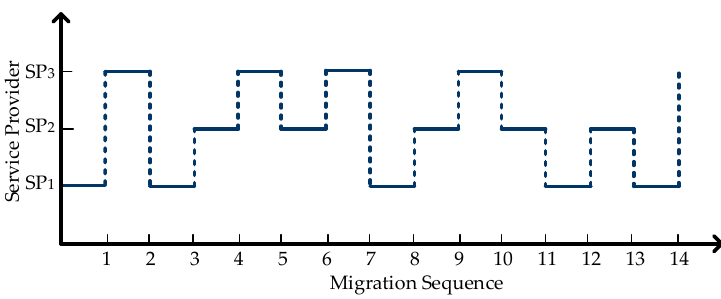
Figure 10. The sequence in time of migration node.